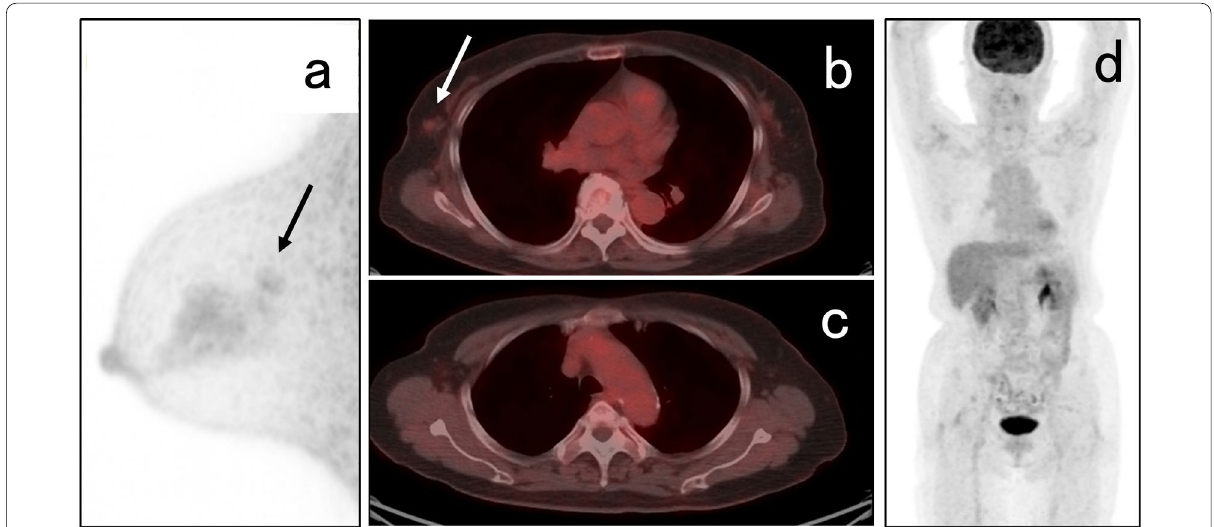
Fig. 4 Findings of db-PET and whole-body PET–(CT). a , b Uptake with SUVmax 2.1 and 1.4 (arrows) in right breast. c , d Uptake is not significant in right axilla and organs. CT computerized tomography, dbPET dedicated breast positron emission tomography, SUVmax maximum standard